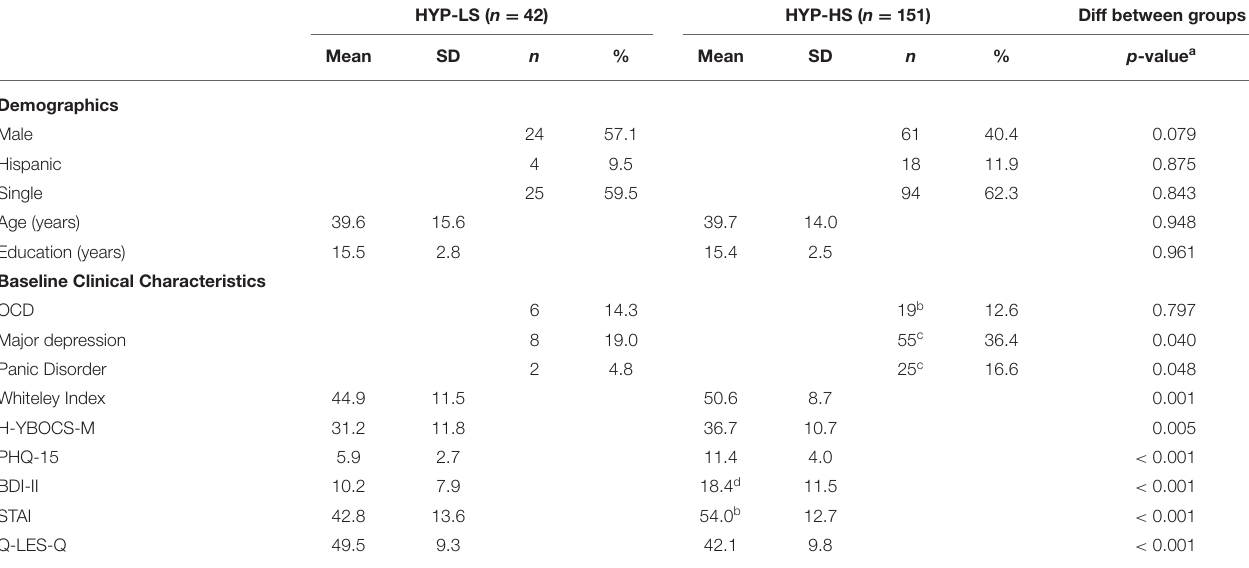
TABLE 1 | Demographic and Clinical characteristics.